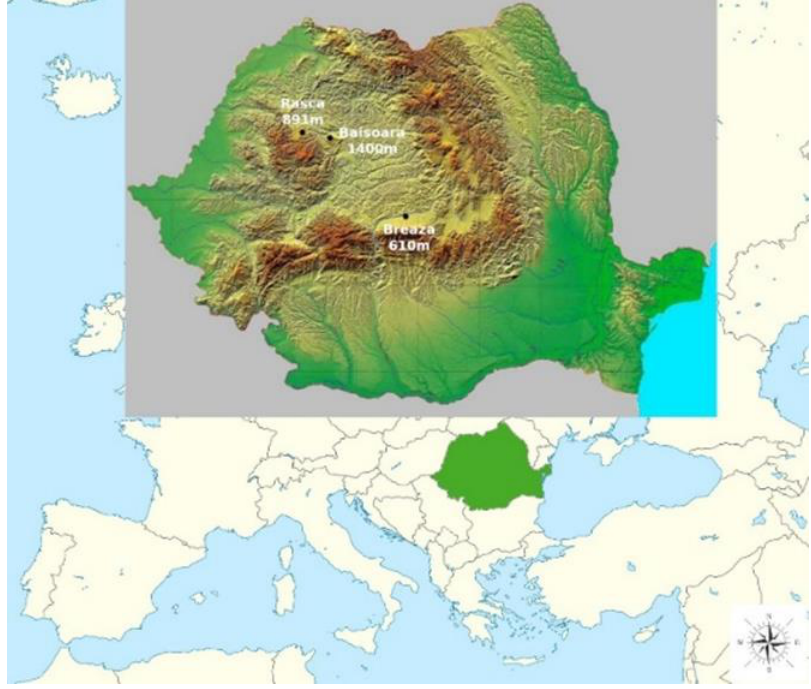
Figure 1. The map of berry samples provenance.